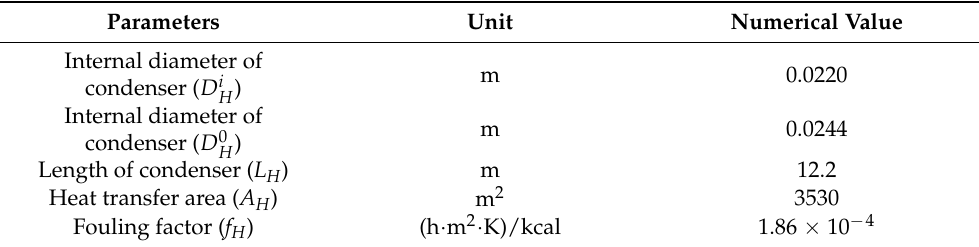
Table 1. Brine heater parameters of the multistage flash (MSF)